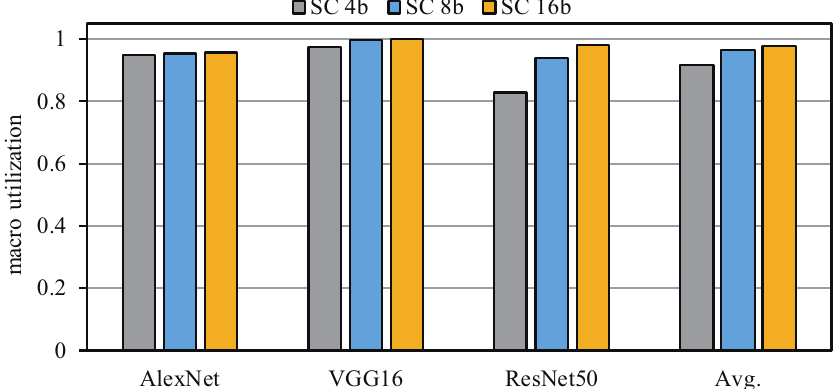
Figure 14. Utilization for different bit widths with different